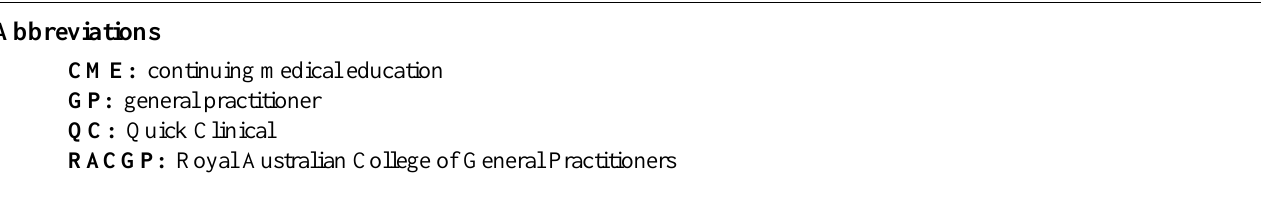
RACGP: Royal Australian College of General